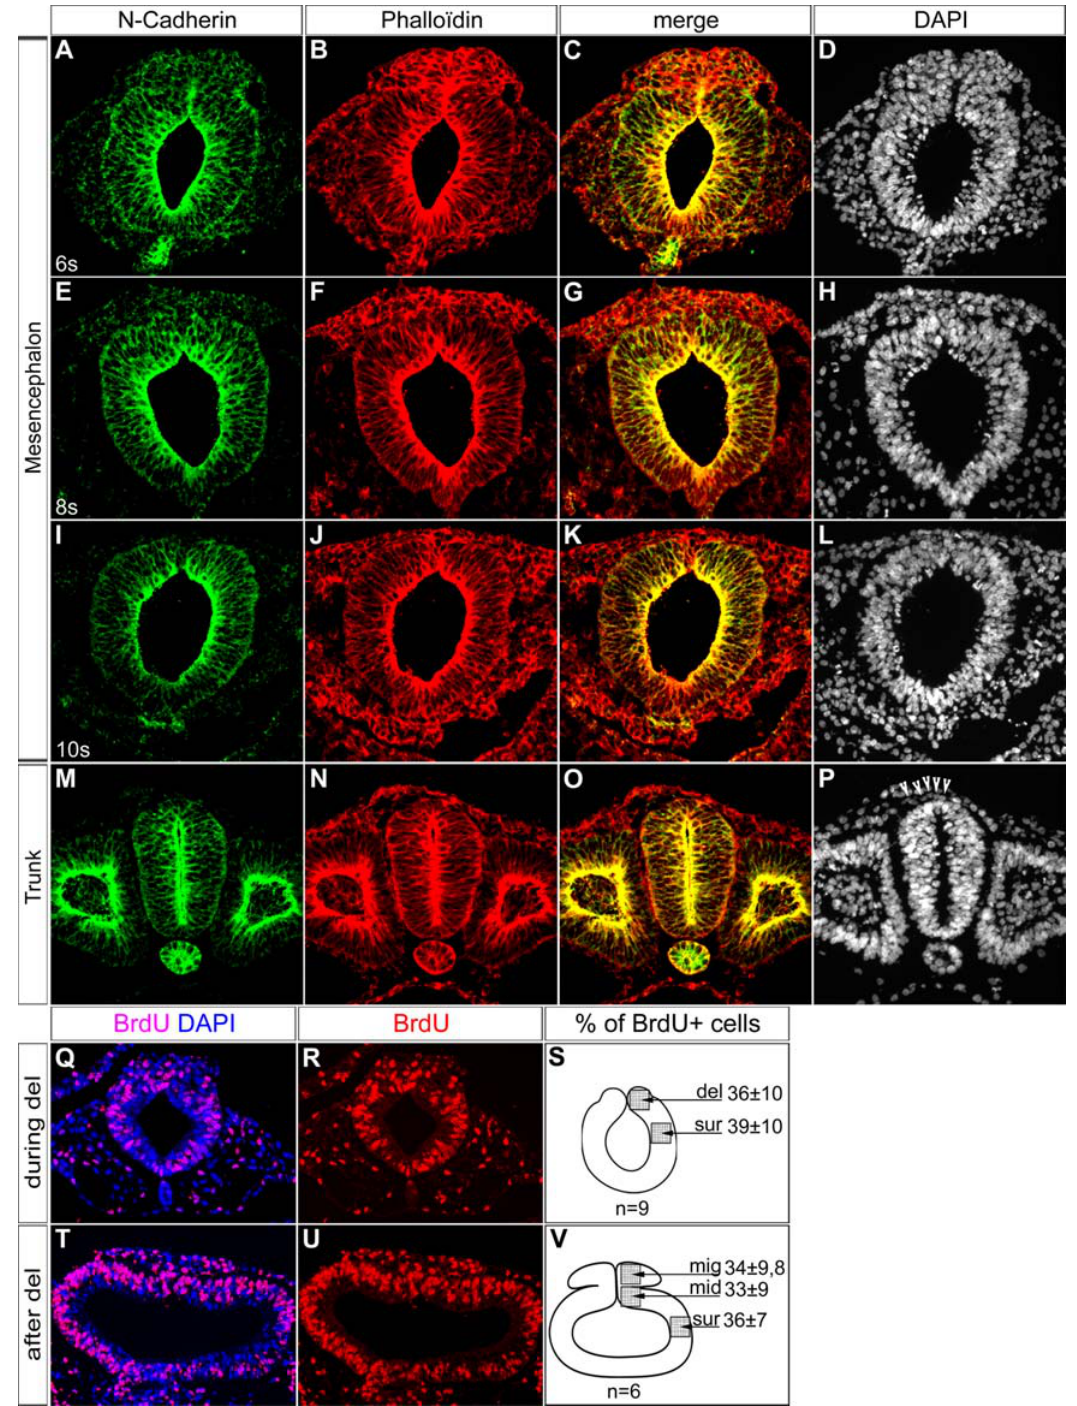
Figure 1. Description of the Cranial Neural Crest Cells Delamination. (A–P) Transversal cryosections (10 m m) of normal chick embryos at stages 6s (A–D), 8s (E–H), 10s (I–L) and HH14 (M–P) at cranial (A–L) and trunk (M–P) levels. Sections were assayed for N-Cadherin expression by immunofluorescence (A, C, E, G, I, K, M, O). The actin microfilaments and the nuclei were stained by Phalloidin (B, C, F, G, J, K, N, O) and DAPI incorporation (D, H, L, P) respectively. During delamination of cranial NCCs there is a massive accumulation of cells in the dorsal part of the neural tube (A–D). In this cell population, colocalisation of N-Cadherin and Phalloidin is lost indicating that they undergo an EMT (C, G, K). By contrast, during trunk delamination, NCCs emigrate one by one. No particular distortion of the dorsal neural tube is detectable (M-P, arrow heads). (Q–V) Analysis of BrdU incorporation in cranial neural tube during and after NCC delamination. Transversal cryosections (5 m m) of stages HH8–9 embryos, during and after delamination, labeled by immunofluorescence using anti-BrdU antibody (Q, R, T, U). Nuclei are stained by DAPI. Percentages of BrdU positive cells in the different zones of the neural tube are represented in diagrams (S,V). Cranial NCCs are not synchronized in S-phase during delamination (Q–R) or migration (T–U). del, delaminating cells; sur, surrounding region; mid, midline region; mig; migrating cells.